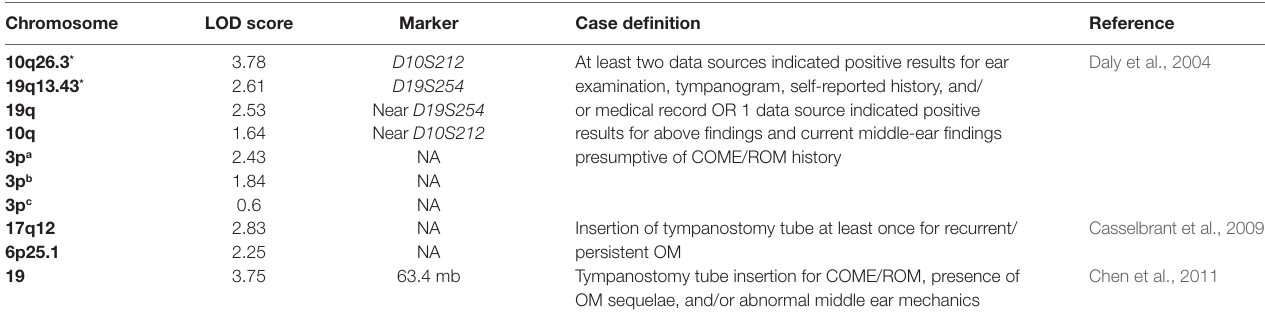
TABLe 2 | List of chromosomes implicated in otitis media based on various nonparametric linkage